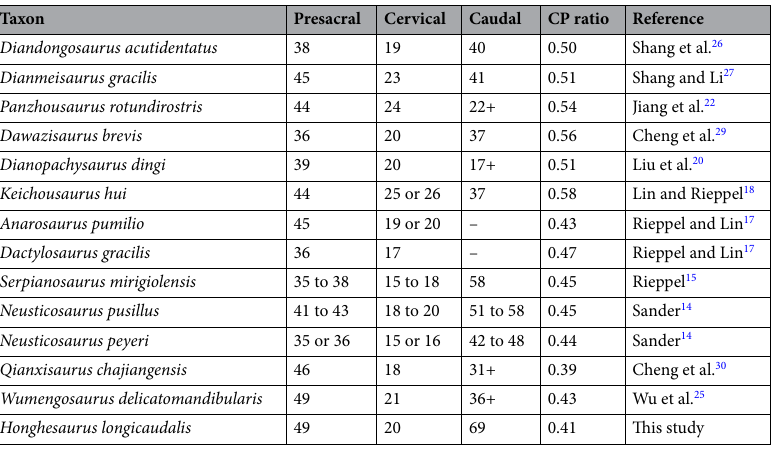
Table 2. Meristics for presacral, cervical and caudal vertebrae in pachypleurosaurs with relatively complete skeletons. The CP ratio means the ratio between the number of cervical vertebrae to all presacral